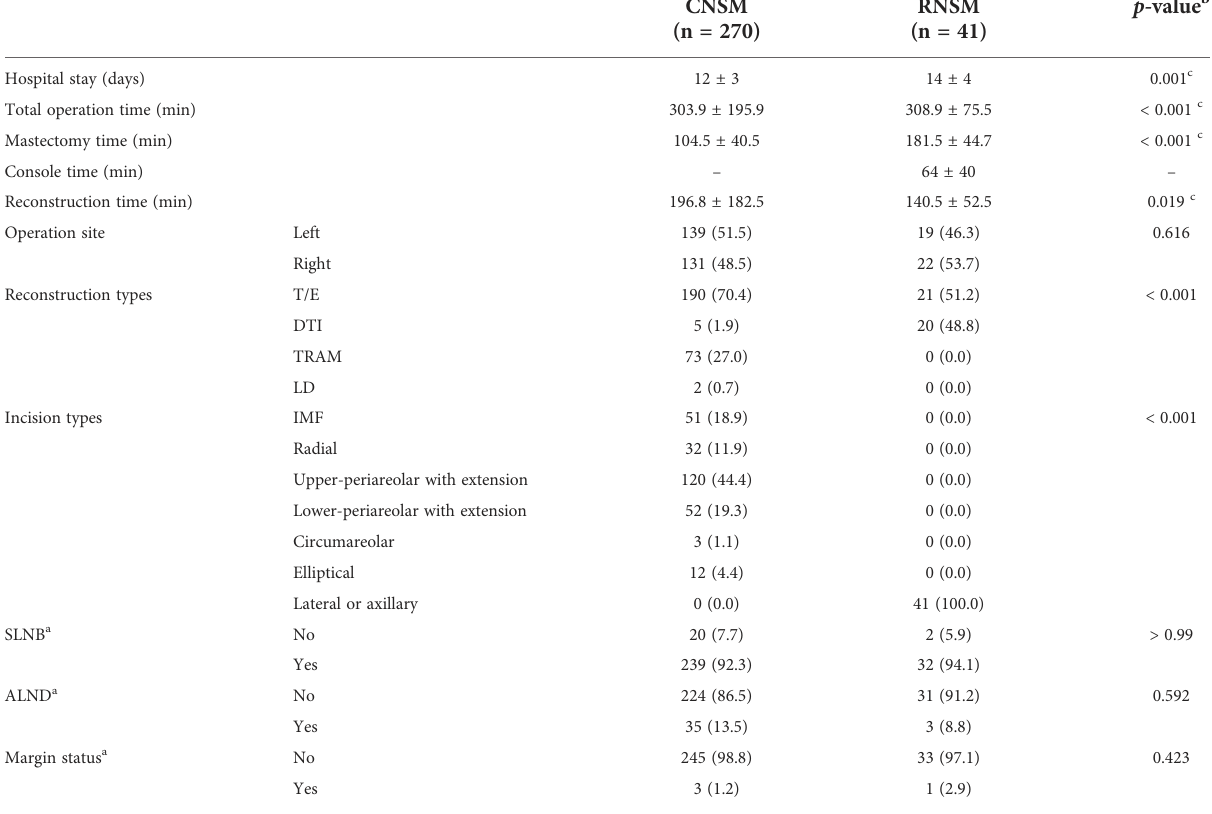
TABLE 2 Surgical methods and post-operative